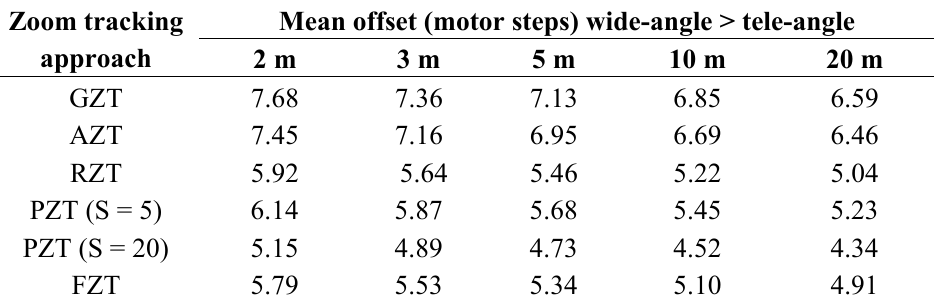
Table 1. Tracking accuracy for stationary